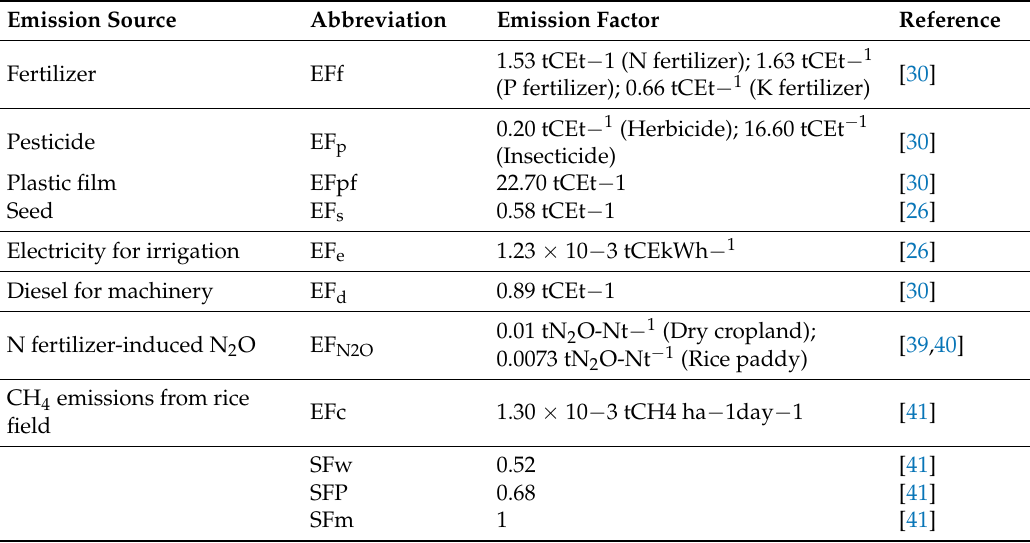
Table 1. Emission factors for agricultural inputs and sources.